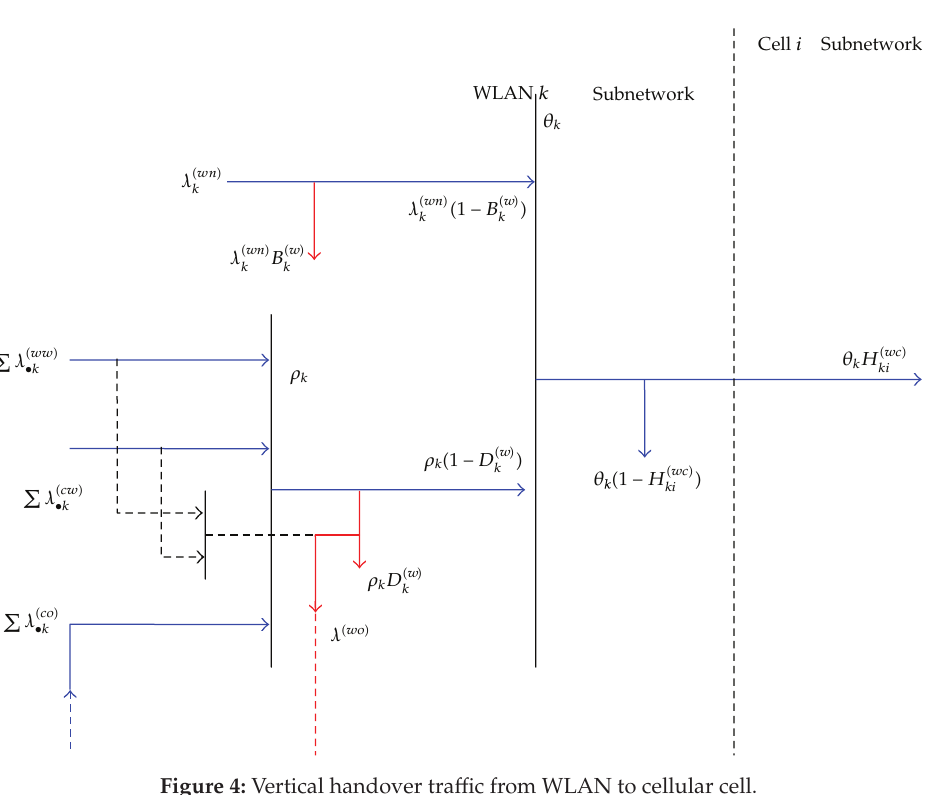
Figure 4: Vertical handover tra ffi c from WLAN to cellular